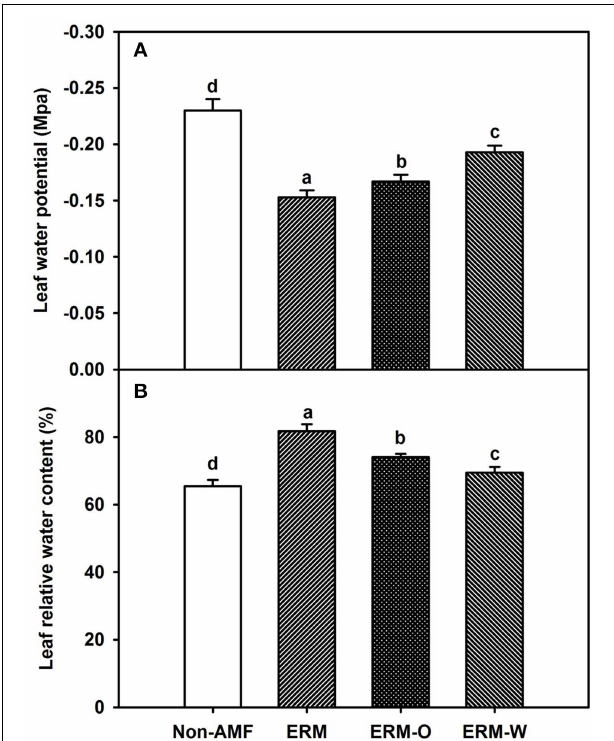
FIGURE 3 | Effects of extraradical mycelium (ERM) status on leaf water potential (A) and leaf relative water content (B) in trifoliate orange ( Poncirus trifoliata ) seedlings inoculated with or without Funneliformis mosseae and grown in 37 µ m nylon-mesh separated root/hyphae compartments. Data (means ± SD, n = 3 ) followed by different letters above the bars among treatments indicate significant differences at the 5% level. Abbreviation: ERM, the plants of the root compartment carrying inoculation with Funneliformis mosseae ; ERM-O, the plants of the root compartment carrying inoculation with F . mosseae , coupled with an ERM network of air gap cut only one time before 8h of the harvest; ERM-W, the plants of the root compartment carrying inoculation with F. mosseae , coupled with an ERM network of air gap cut at weekly interval after 14 days of inoculation; Non-AMF, the plants of the root compartment carrying the inoculation without F. mosseae .